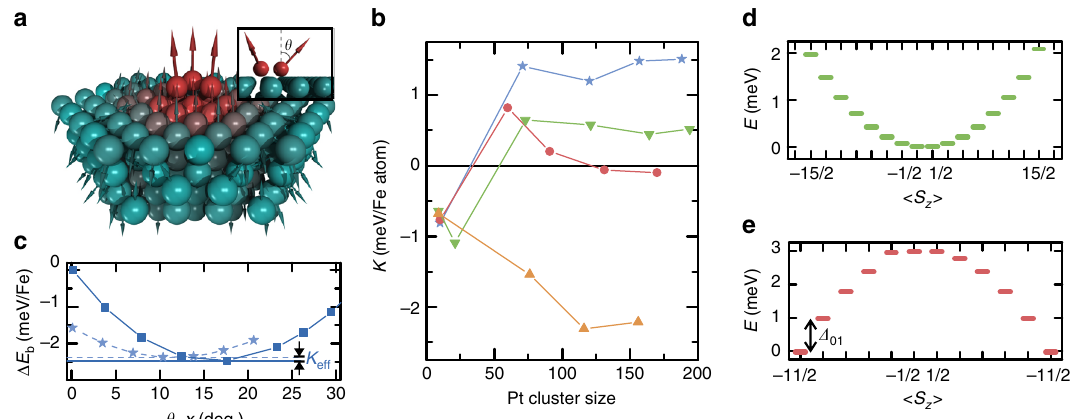
Fig. 2 Magnetic anisotropy and energy level schematics of the giant moment clusters. a Model of the hcp-top Fe 3 cluster on the Pt surface resulting from the ab-initio (KKR) calculations indicating the strong non-collinearity of the magnetic moments ( arrows ) in the cluster and the polarization ( color ) in the Pt. The inset shows the de fi nition of the non-collinearity angle θ . b Collinear ab-initio calculated MAE of the hcp hollow ( green ), the hcp top ( blue ), the fcc hollow ( orange ), and the fcc top ( red ) cluster geometries as a function of the number of considered Pt atoms. c DFT non-collinear band-energy calculations (energy per Fe atom) of the hcp top cluster as a function of the non-collinearity angles. The data points depict the energy evolution of nearly out-of-plane ( squares ) and in-plane ( stars ) spin con fi gurations, respectively (see Supplementary Figs. 3 and 4). The origin of the energy axis has been set with respect to the band-energy of the collinear ( θ = 0) out-of-plane con fi guration. The horizontal solid and dashed lines , respectively, denote the minimum band-energy of the nearly out-of-plane and in-plane con fi gurations, whose difference de fi nes the effective anisotropy K eff . d , e Schematic diagrams of energy levels in zero magnetic fi eld for the easy-plane case of the hcp hollow cluster ( d , K ; Dð Þ > 0) and the out-of-plane case of the fcc top, fcc hollow, and hcp top clusters ( e , K ; Dð Þ < 0), illustrating the effective spin model used for the simulation of the magnetization dynamics. Δ 01 in e denotes the splitting between the ground and fi rst excited